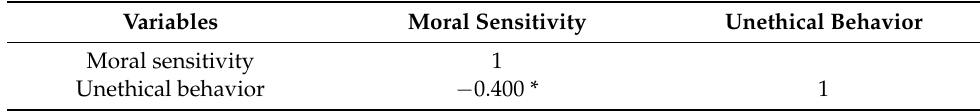
Table 3. Correlations among the variables ( n = 35) at